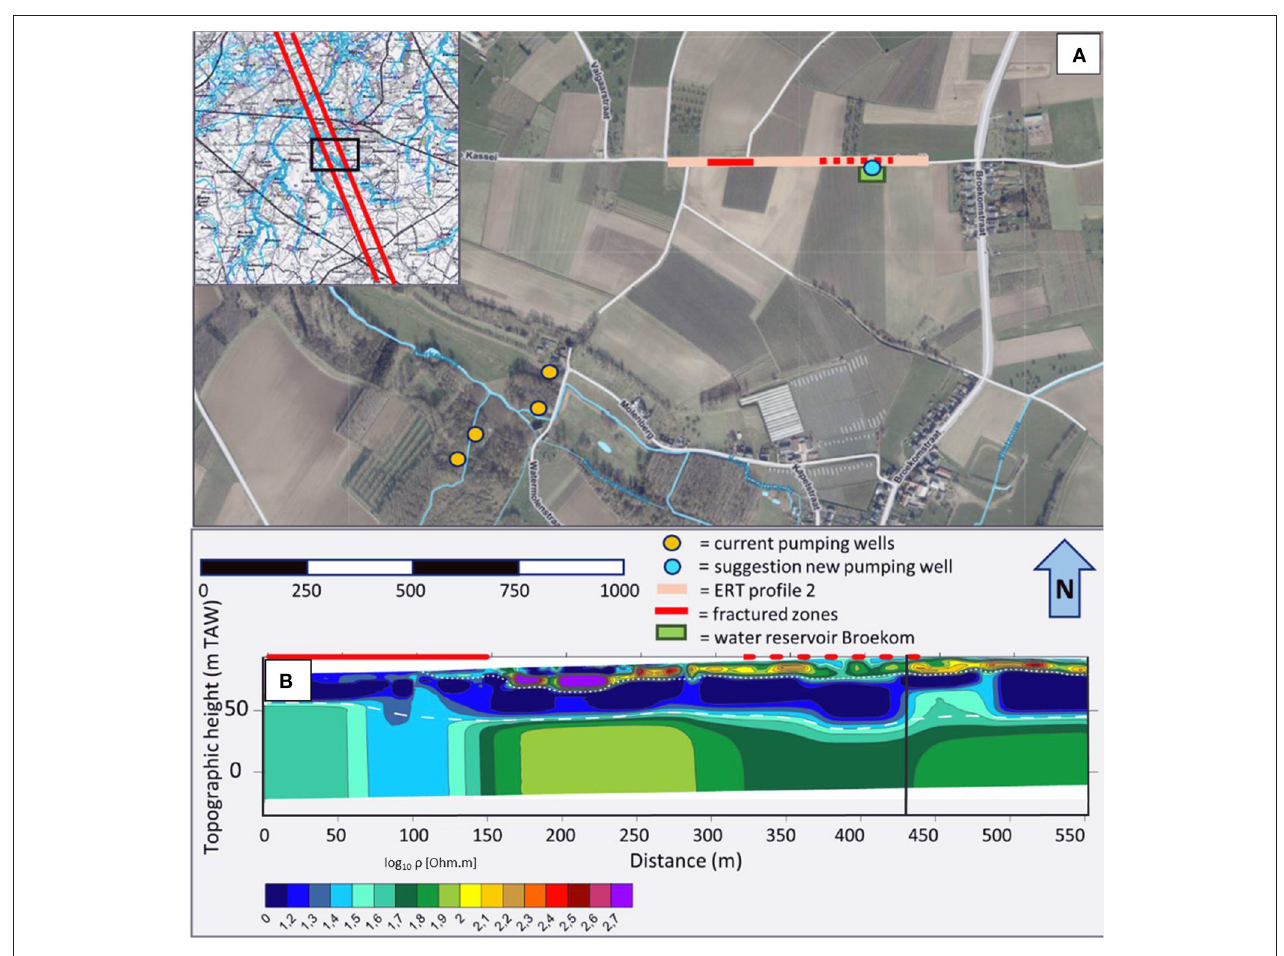
FIGURE 9 | Location of the new pumping well-based on ERT. (A) Aerial view of the study area. (B) Location of the well on the ERT profile.